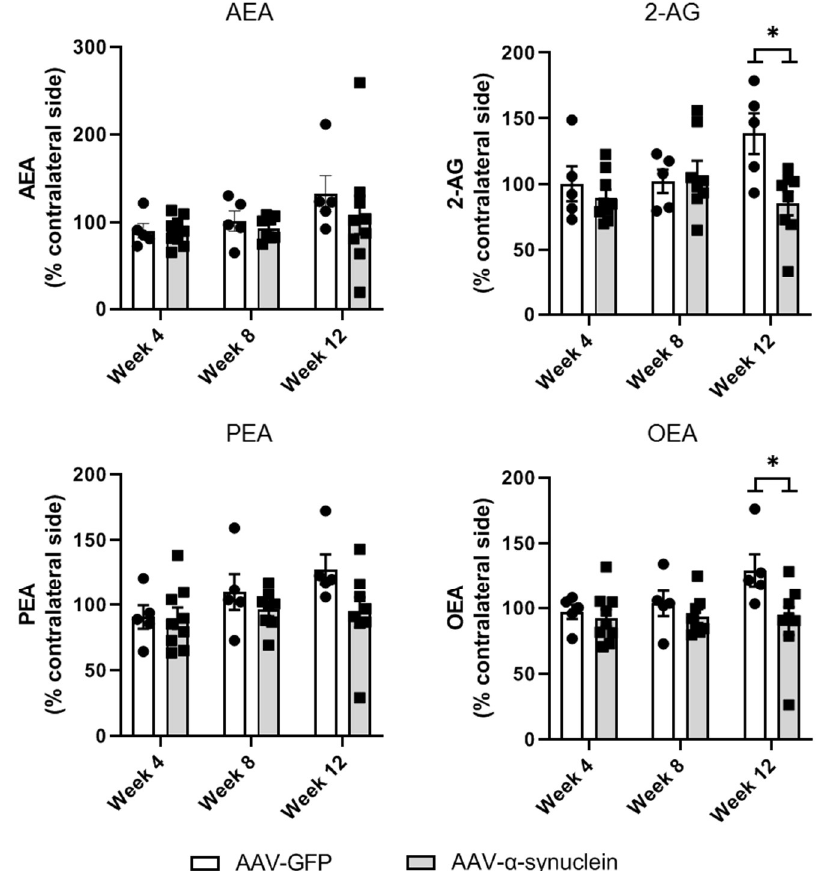
Figure 7. LC-MS/MS measurements of striatal endocannabinoid levels. Unilateral intranigral AAV- α -synuclein did not alter striatal AEA or PEA levels but induced a reduction in the levels of 2-AG and OEA at Week 12. Data are analysed as mean ± SEM with 5–9 animals per group. * p < 0.05 vs. corresponding AAV-GFP group by two-way ANOVA with post hoc Tukey.